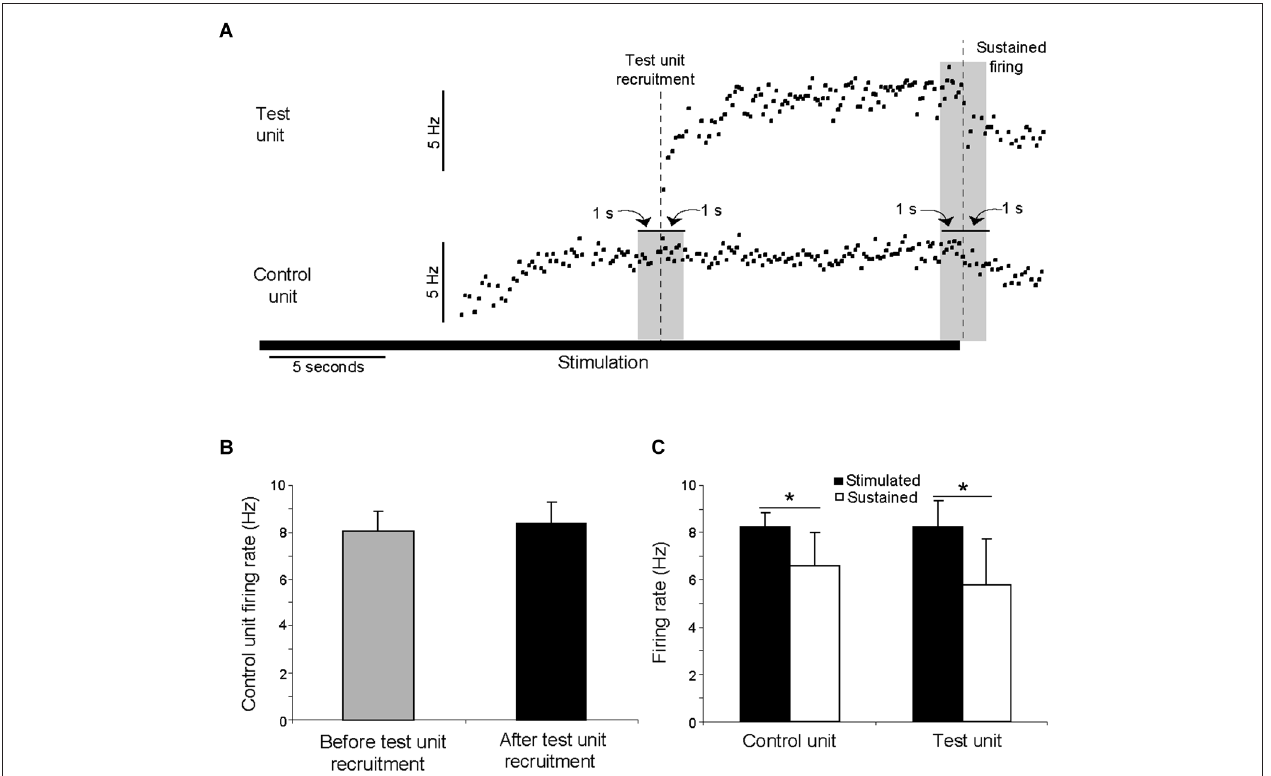
discharge rates of both units decreased when stimulation ended. (B) In ten instances, a control unit fired at its steady-state frequency for at least one second before a test unit was recruited. The discharge rate of the control unit during the 1 s period prior to the recruitment of the test unit was not significantly different than the discharge rate during subsequent 1 s period ( p > 0.05). (C) For the same ten instances, the discharge rate of both the control and test unit decreased significantly ( p < 0.05) once the stimulation